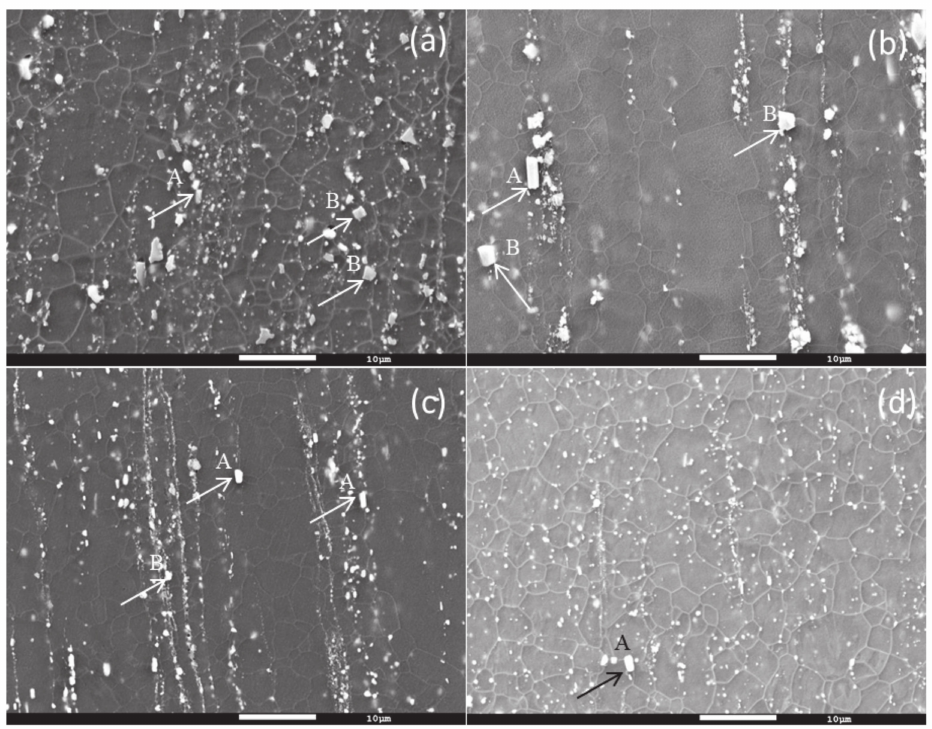
Figure 3. Scanning electron micrographs of ( a ) Mg-5Sn ( b ) Mg-5Sn-0.5Y ( c ) Mg-5Sn-1Y and ( d ) Mg-5Sn-2Y. (A = Oblong/Rod shaped and B = Polygonal).